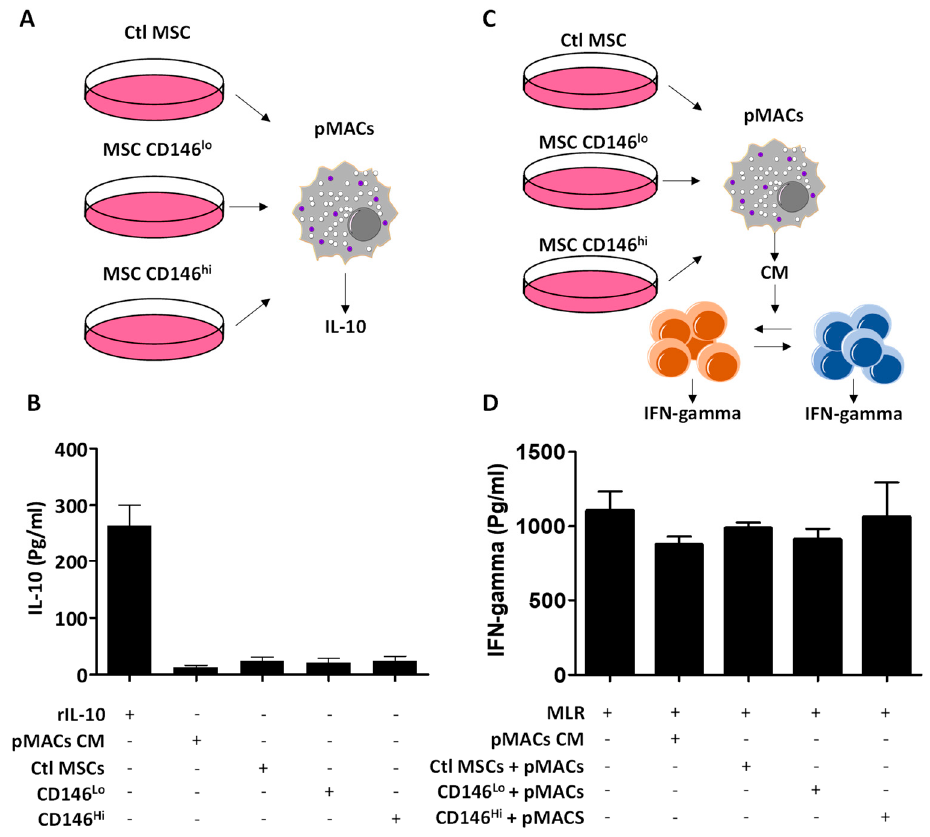
Figure 4. The inhibitory effect of MSCs is independent of pMAC-derived soluble mediators. ( A ) Schematic diagram showing the experimental design used to assess IL-10 production from pMACs treated with MSC-derived conditioned media. ( B ) IL-10 quantification for the experiment shown in panel A. ( C ) Schematic diagram showing the experimental design used to assess IFN-gamma production from a two-way MLR treated with pMACs cultured with MSC-derived conditioned media. ( D ) IFN-gamma quantification from the experiment shown in panel D. For panels B and D, n = 5/group.